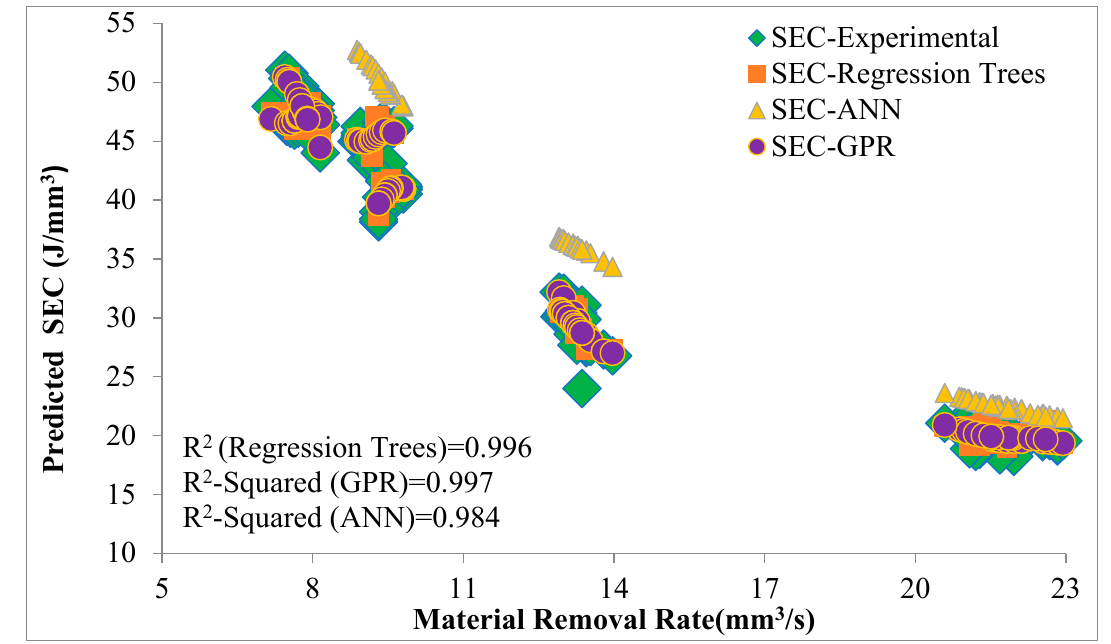
Figure 12. Validation of predicted SEC.